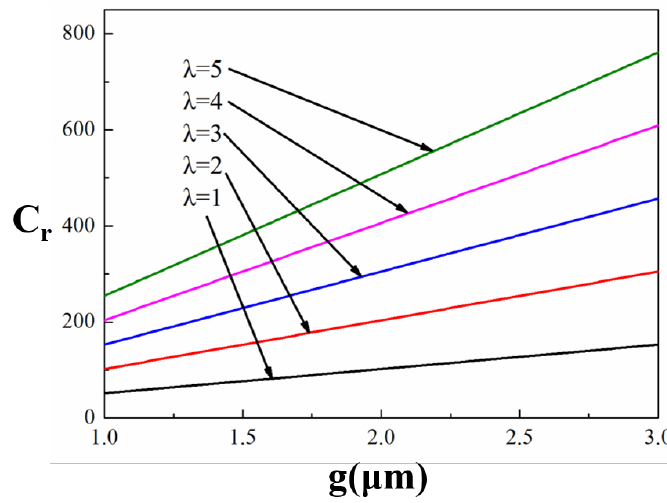
Figure 6. The relationship between the parameters of g , Cr and λ .